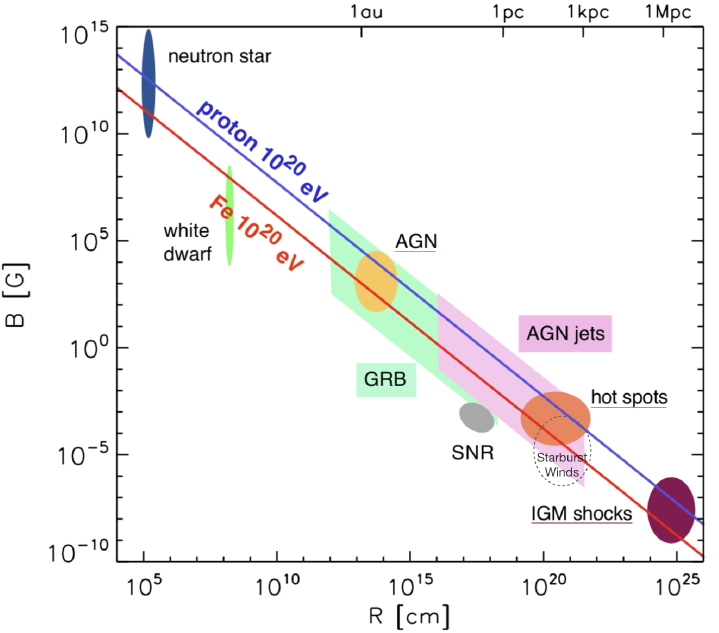
Figure 8. Updated Hillas diagram [7], obtained by requiring the Larmor radius for a 10 20 eV particle to be smaller than the characteristic source size R . The blue line and the red line show the limits for protons and iron nuclei, respectively. Shown also are astrophysical objects that can meet the requirements on source size and magnetic field B (above the respective lines). AGN (radio galaxies) typically represent suitable environments. Adapted based on ref.